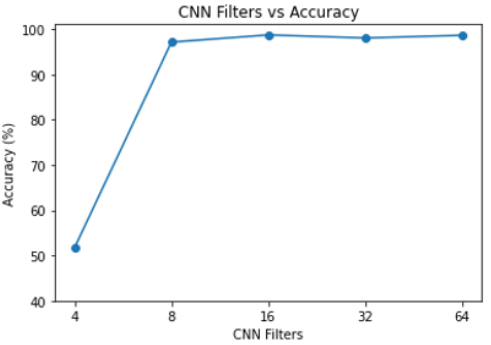
Figure 11. Accuracy associated with varied number of CNN Filters.